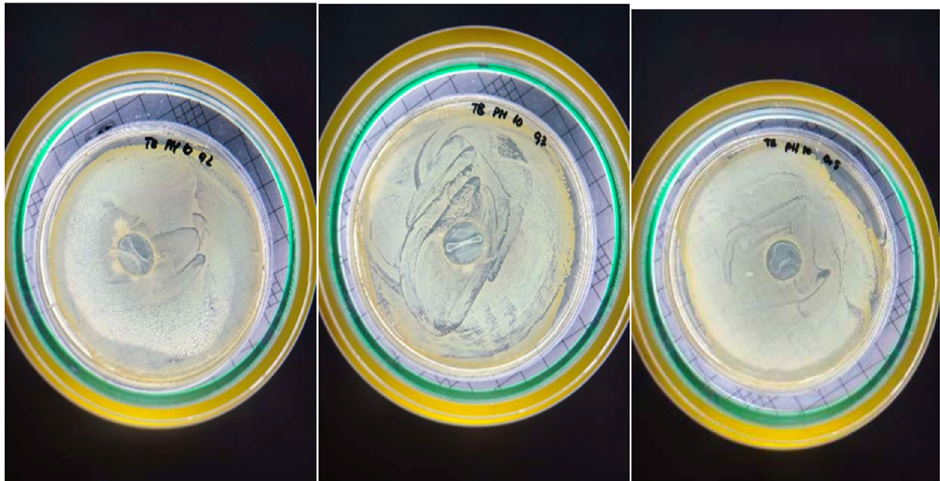
Figure 6. Comparison of the antibacterial tests of the CS-Tb 2 S 3 NCs prepared at a pH of 10 onto contact lens surfaces.